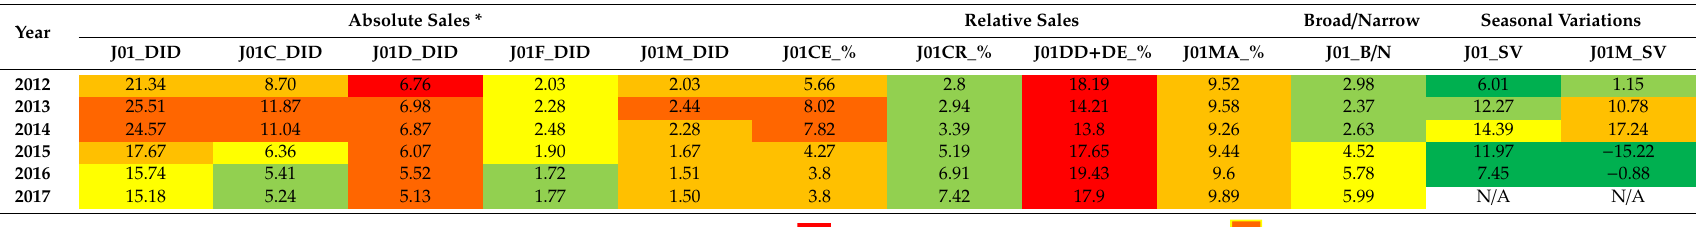
Table 3. Quality indicators for antibiotic sales in outpatient in Hubei in comparison with 31 European countries (highlighted in di ff erent colours).